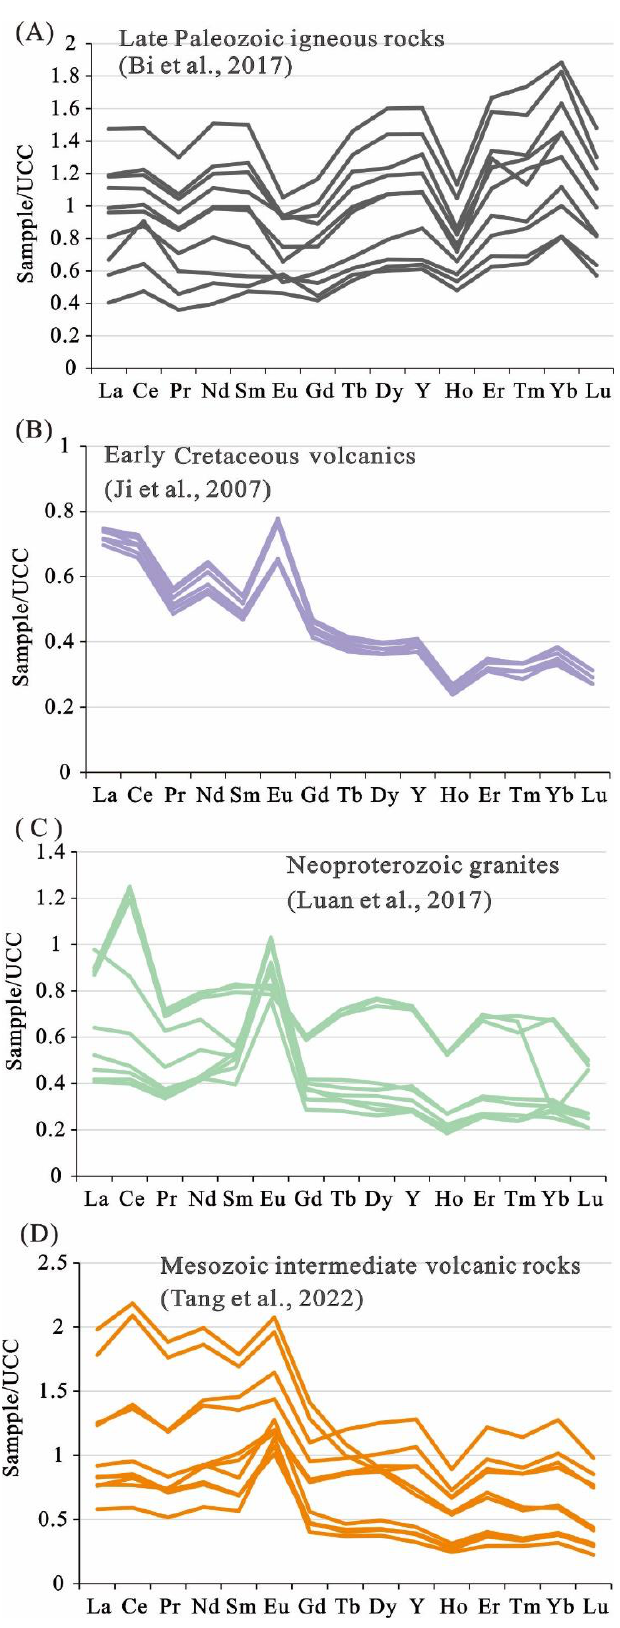
Figure 14. Comparison of ( A ) Al 2 O 3 /TiO 2 vs. Sr/Y and ( B ) Al 2 O 3 /TiO 2 vs. La/Yb between the studied samples, and the local (the Jiamusi block) rocks of Neoproterozoic, Late Paleozoic, Mesozoic and Cretaceous ages [66 – 69].